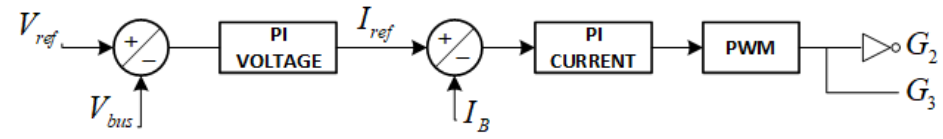
Figure 7. Control strategy for the storage system.